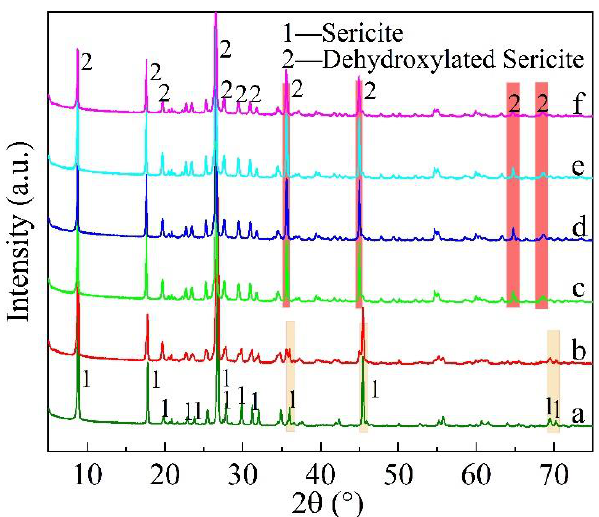
Figure 6. XRD analysis of roasted products at different temperatures (raw ore ( a ), 700 °C ( b ), 850 °C ( c ), 900 °C ( d ), 950 °C ( e ), and 1050 °C ( f )).